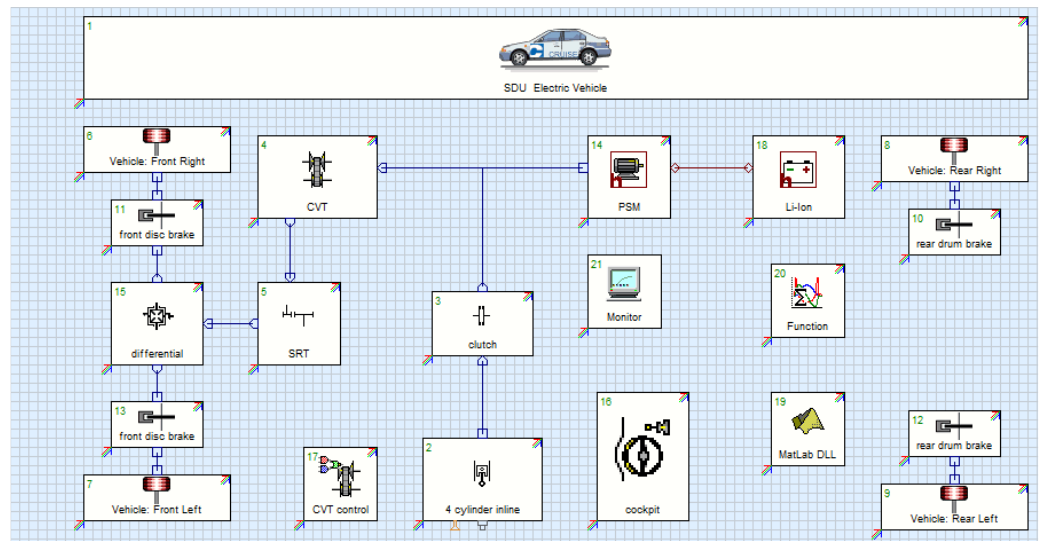
Figure 14. The designed parallel hybrid electric vehicle (PHEV) model in AVL Cruise.